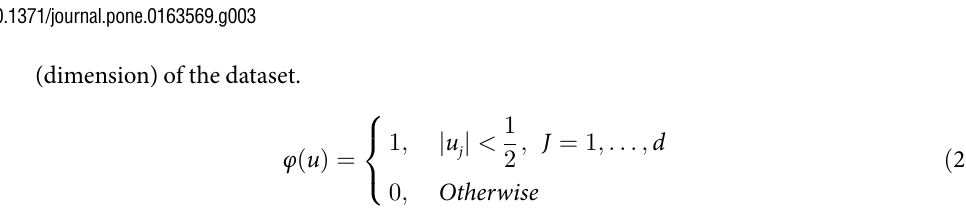
Fig 3. The matrix creation process used in the study (Amps. (n-m) means the class-n data of nth EEG channel signal).